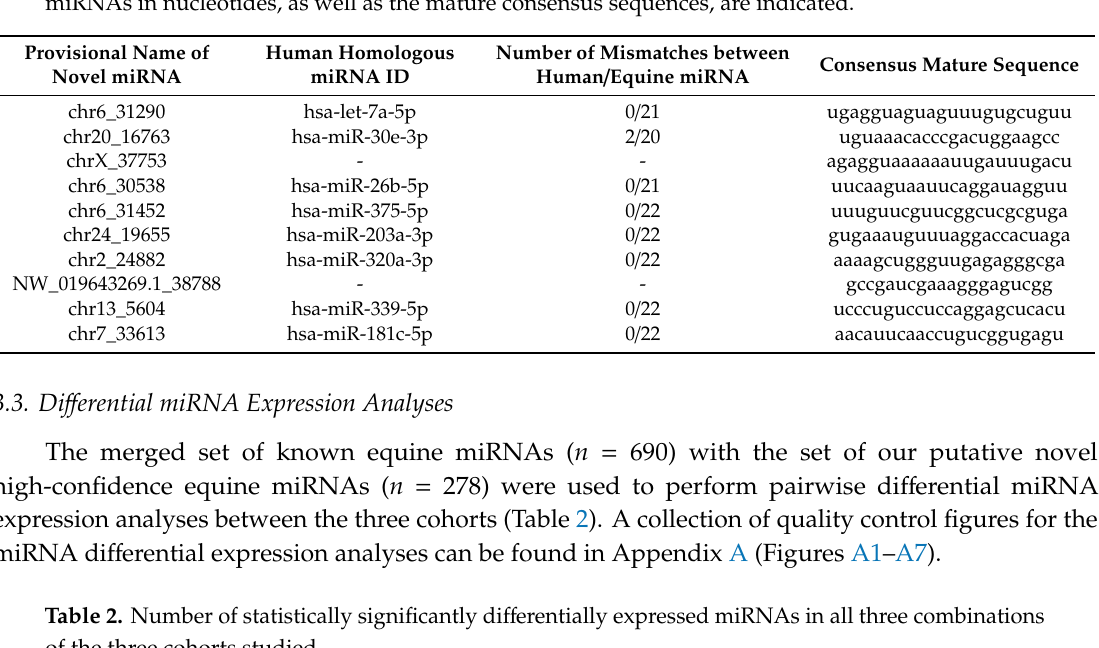
Table 1. Table of the top 10 putative novel equine miRNAs detected in this dataset ranked according to decreasing probability of the novel miRNA to be a true positive (represented by the miRDeep2 score; Supplementary Table S1). Additionally, the number of mismatches and the length of the putative novel miRNAs in nucleotides, as well as the mature consensus sequences, are indicated.